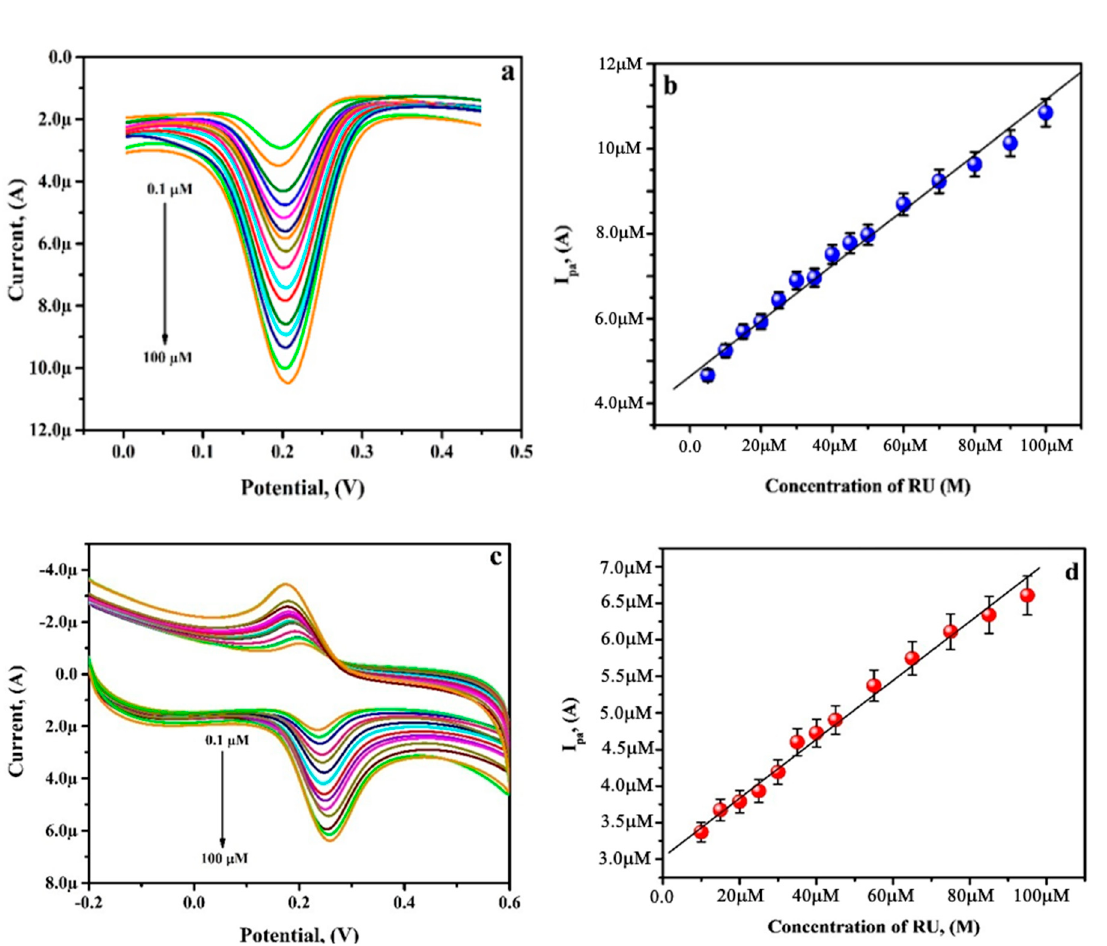
Figure 9. ( a ) DPVs for varying concentrations of RU ranging from 0.10 to 100.0 µM in PB on PGAMGPE. ( b ) Plot of [RU] versus I pa . ( c ) CVs for varying RU concentrations ranging from 0.10 to 100.0 µM, in PB at PGAMGPE. ( d ) Plot of [RU] versus I pa.